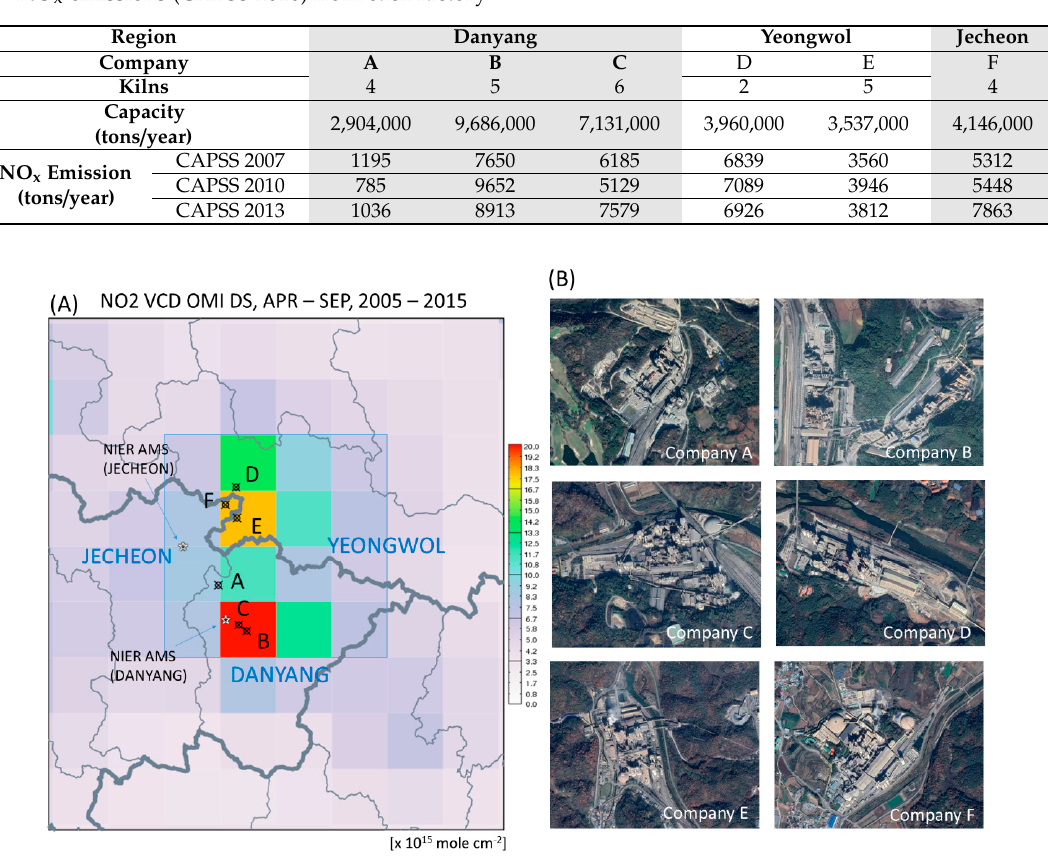
Figure 2. ( A ) Geographical locations of six cement factories in the Yeongwol-Danyang-Jecheon (YDJ) region and of National Institute of Environmental Research (NIER) Ambient Monitoring System (AMS) surface-monitoring sites (Jecheon and Danyang) over the OMI NO 2 VCD distribution (April–September average from 2005 to 2015, Downscaled). ( B ) Satellite pictures of factories.